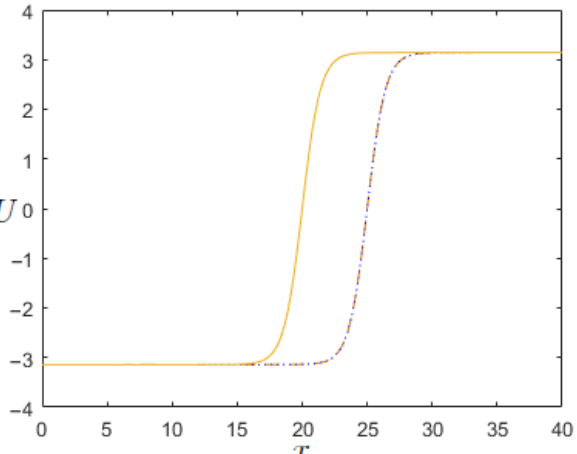
Figure 4. U computed by the numerical scheme ( 6 ) – ( 8 ) with h = 0.1 and τ = 0.0125. Comparison between the exact solution and the numerical solution at time T = 50. Initial condition (solid line); exact solution (dotted line); and numerical solution (dashed line).